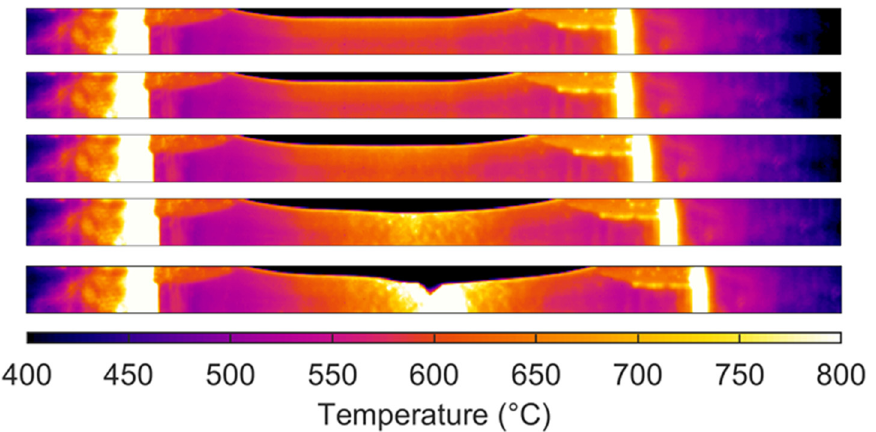
Figure 12. Thermal images acquired by the infrared camera during a high strain rate test at 600 °C: image resolution, 640 × 36 pixels; frame rate, 10,000 fps; integration time, 6.1 μ s.